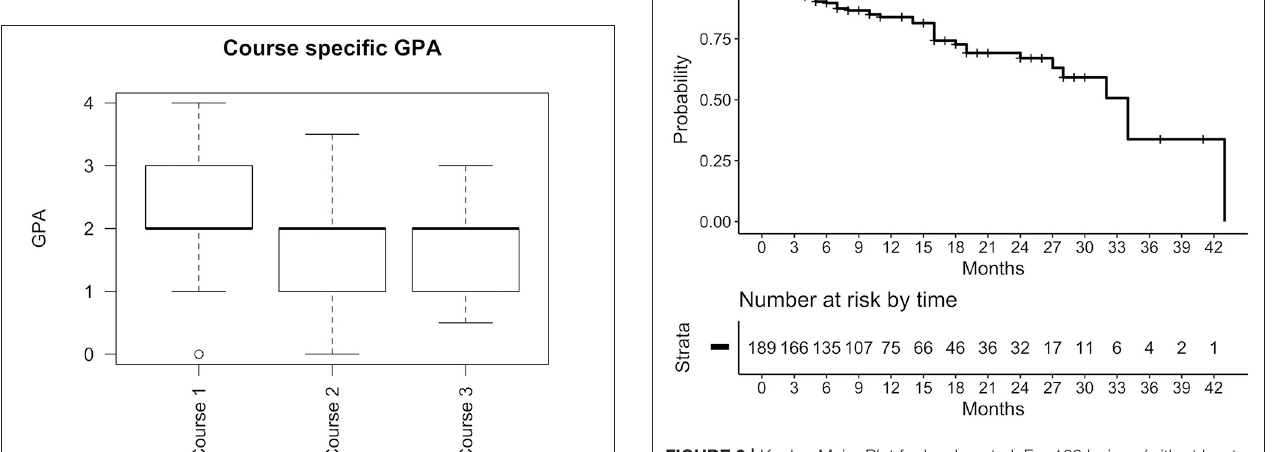
Frontiers in Oncology |